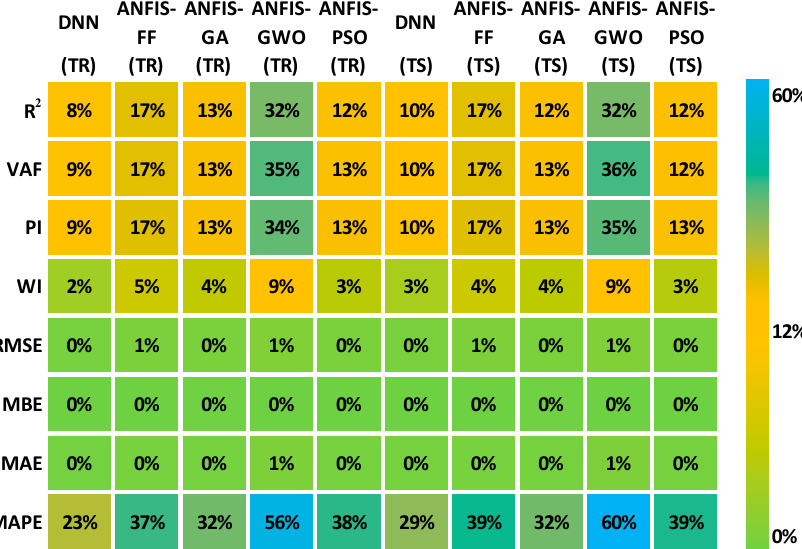
Figure 16. Error matrix for lateral ( x ) direction (TR for training and TS for testing).